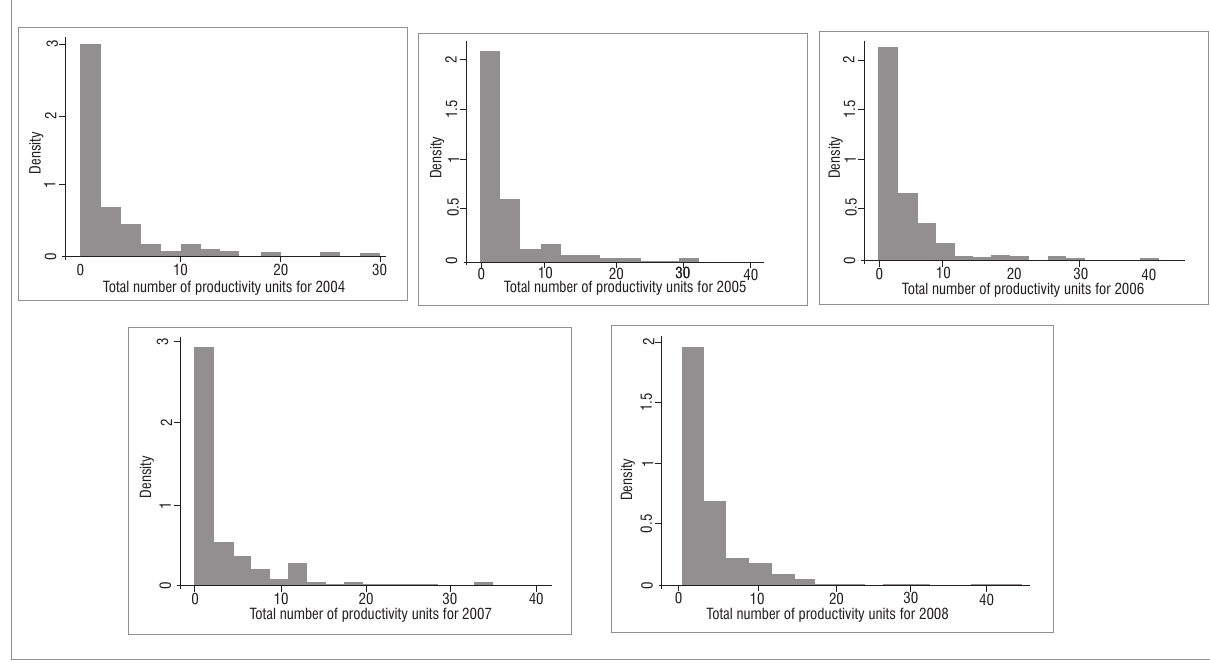
A set of observed sampling distributions for the number of productivity units generated in each year from 2004 to